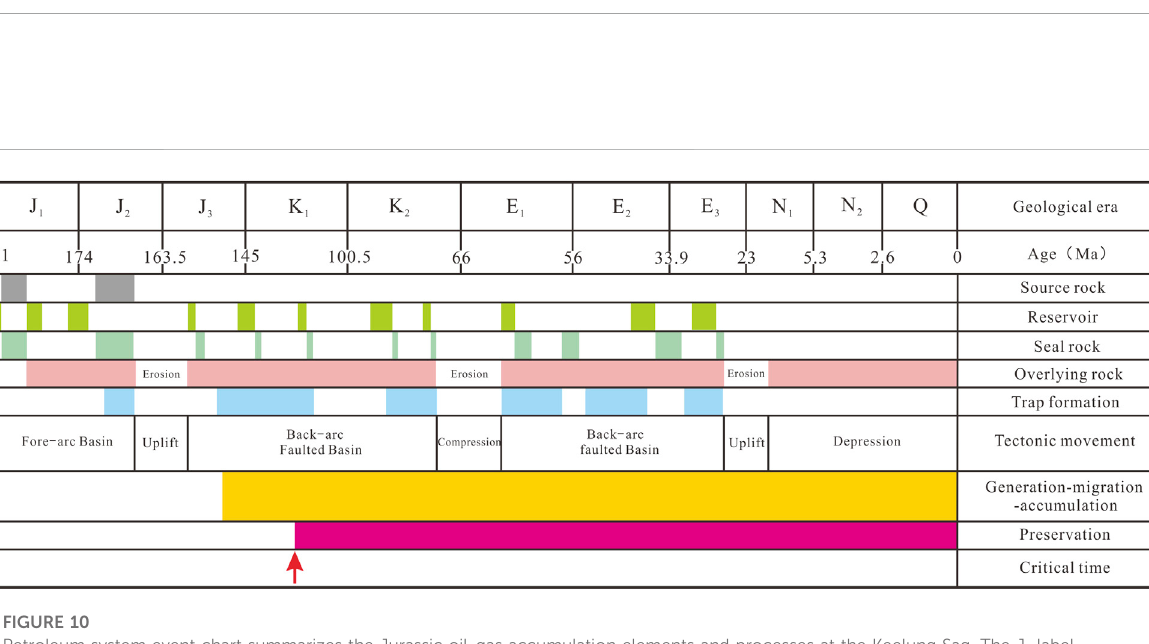
Petroleum system event chart summarizes the Jurassic oil-gas accumulation elements and processes at the Keelung Sag. The J 1 label represents the Early Jurassic; J 2 represents the Middle Jurassic; J 3 represents theLate JurassicK 1 represents the Early Cretaceous; K 2 represents the LateCretaceous;E 1 representsthePaleocene; E 2 representstheEocene;E 3 representstheOligocene; N 1 representstheMiocene;N 2 representsthe Pliocene; and Q represents the Quaternary.